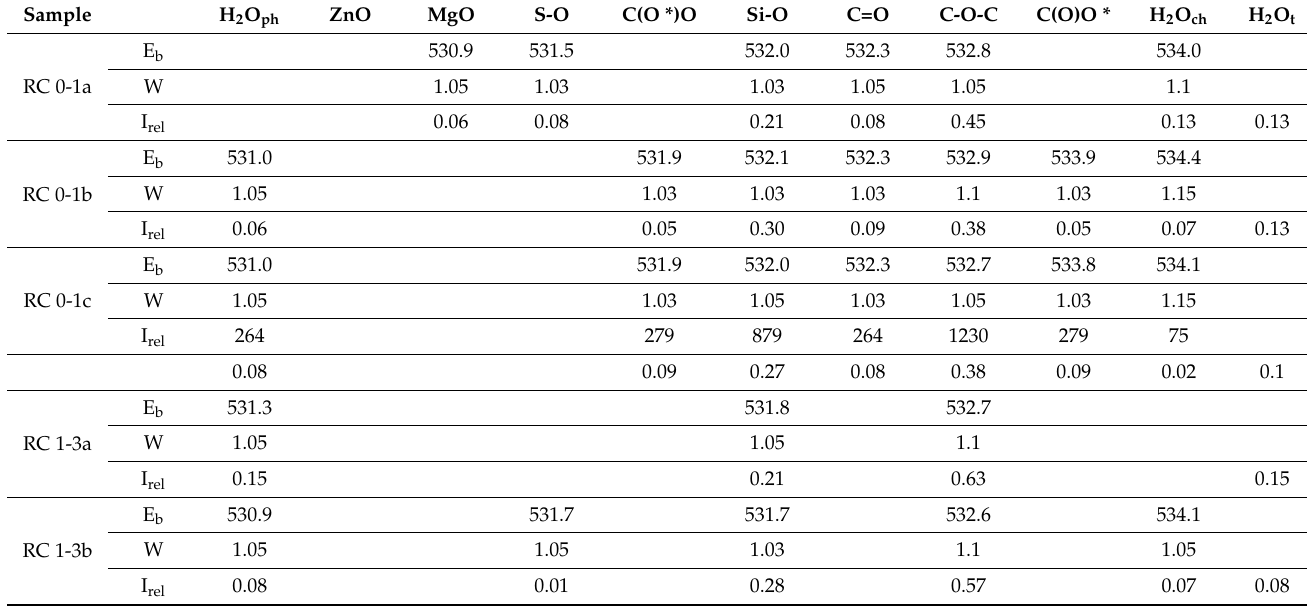
Figure 6. O 1s photoelectron spectra of rubber crumbs, measured in different areas: RC 0-1 — a ( 1 ), b ( 2 ), c ( 3 ); RC 1-3 — a ( 4 ), b ( 5 ), c ( 6 ); RC 3-5 — a ( 7 ), b ( 8 ), c ( 9 ). Table 5. Parameters of components in O 1s photoelectron spectra of rubber crumbs: E b —binding energy, W — peak width, and I rel — relative intensity.